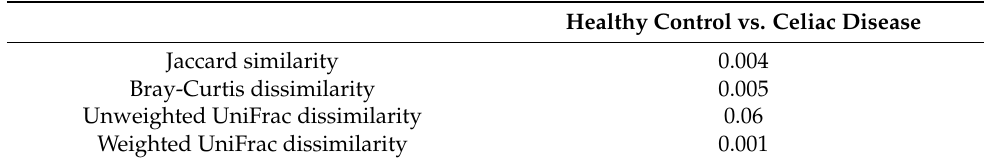
Figure 2 . Principal coordinates analysis plot for HC (blue), and CD patient in GFD (red); distances across samples are calculated through Weighted Unifrac distance. Table 3 . Summary of pairwise group comparisons for beta diversity measures. Benjamini and Hochberg corrected p -values ( q -values) for PERMANOVA tests are shown.